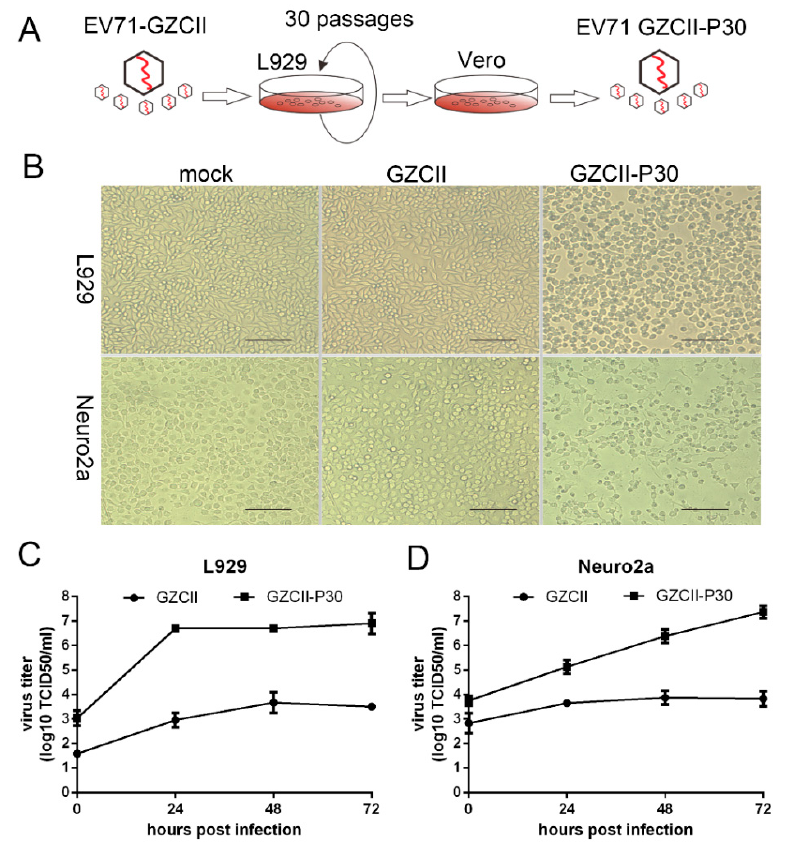
Figure 1. Generation and in vitro characterization of the L929-adapted EV71-GZCII virus. ( A ) EV71-GZCII virus was passaged 30 times in L929 cells to generate the GZCII-P30 strain. ( B ) L929 and Neuro2a cells were infected with GZCII or GZCII-P30 (MOI = 0.1) or mock infected for 24 h. Scale bar: 200 µ m. ( C ) Multistep growth curve of GZCII and GZCII-P30 in L929 and Neuro2a (MOI = 1) cells ( D ). Viral titers were determined by measuring TCID 50 .